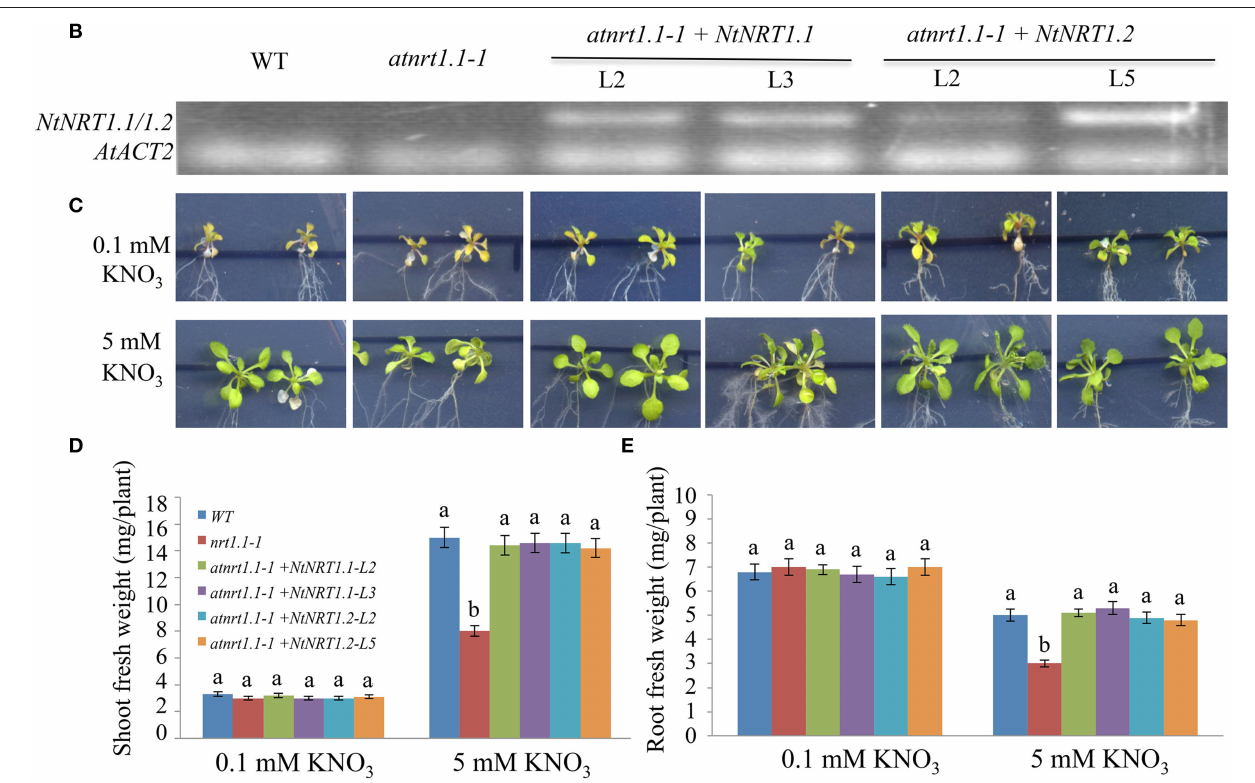
FIGURE 6 | Growth complementation of a yeast or Arabidopsis mutant by heterologous expression of NtAMTs and NtNRTs . (A) Functional complementation of yeast mutant 31019b by the transformation of individual NtAMTs . The yeast strain 23346c ( 1 ura3 ) and 31019b ( 1 mep1-3, 1 ura3 ; defective in NH + 4 uptake) transformed with a yeast expression-vector pHXT426 alone or harboring a putative ORF of NtAMT1.1, 1.2, 1.3, 2.1, 3.1, 4.1, and 4.3 were grown first on SD-medium agar plate containing 20mM NH + 4 as N source. A single colony was picked, suspended in 5 µ l water and streaked onto the SD plate containing 2mM NH + 4 as sole N form. 31019b did not grow on < 5mM NH + 4 . Pictures were taken 5–6 days after yeast growth on NH + 4 medium. P and N, positive and negative control (i.e., 23346c or 31019b harboring just pHXT426). (B–E) Expression of NtNRT1.1/1.2 in an Arabidopsis mutant improved plant growth on nitrate. The putative ORF of NtNRT1.1 or NtNRT1.2 cloned after CaMV 35S-promoter was introduced into the Arabidopsis atnrt1.1-1 line defected in NRT1.1 gene (Hachiya et al., 2011), and two independent transgenic lines of NtNRT1.1- or NtNRT1.2- transformed atnrt1.1 were used in the experiment. (B) Detection of gene expression in transgenic and